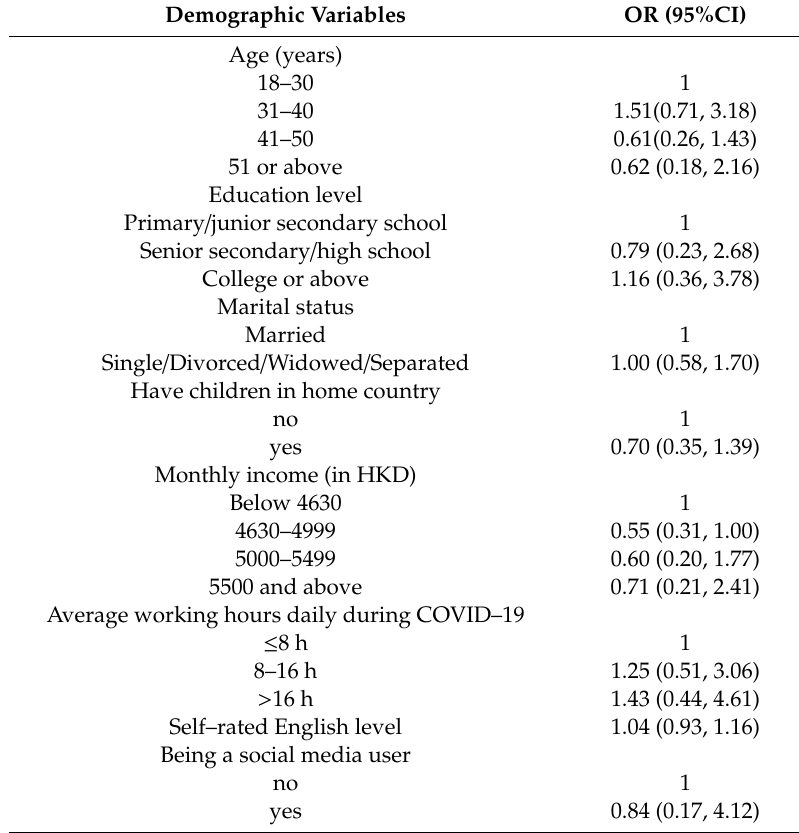
Table 2. Odds ratios and confidence intervals of background variables associated with probable anxiety (General Anxiety Disorder-7 (GAD-7) ≥ 10) ( n =